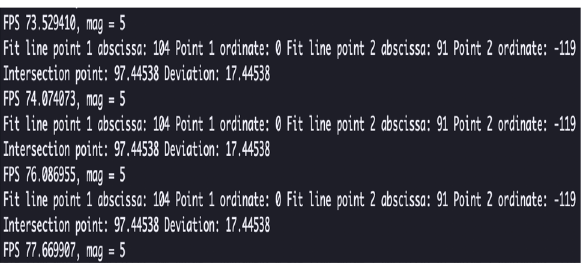
Fig. 10 A schematic view of the iron tube after binarization